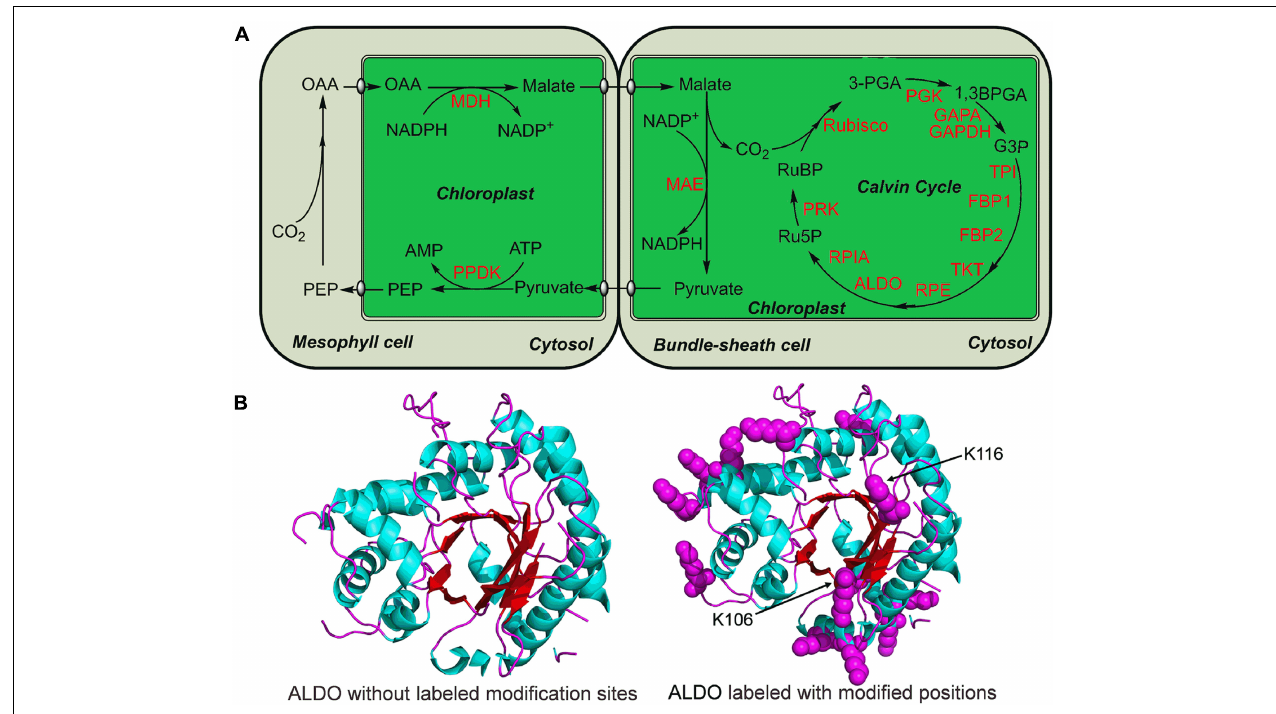
FIGURE 6 | Lysine malonylation enzymes associated with Calvin cycle in maize. (A) Reconstruction of Calvin cycle from the KEGG pathway in maize. The modified enzymes were marked in red. (B) Three-dimensional structure analysis of ALDO. The malonylated residues were labeled with purple balls. The ALDO three-dimensional structure was modeled from PDB